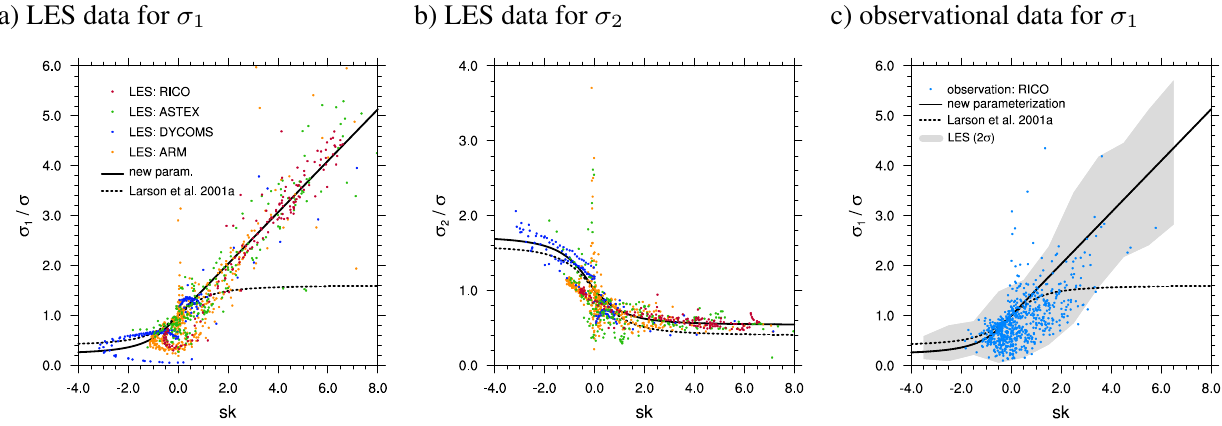
Fig. 3. LES data of ARM, ASTEX, RICO and DYCOMS and observational data from the RICO campaign along with the closure equations